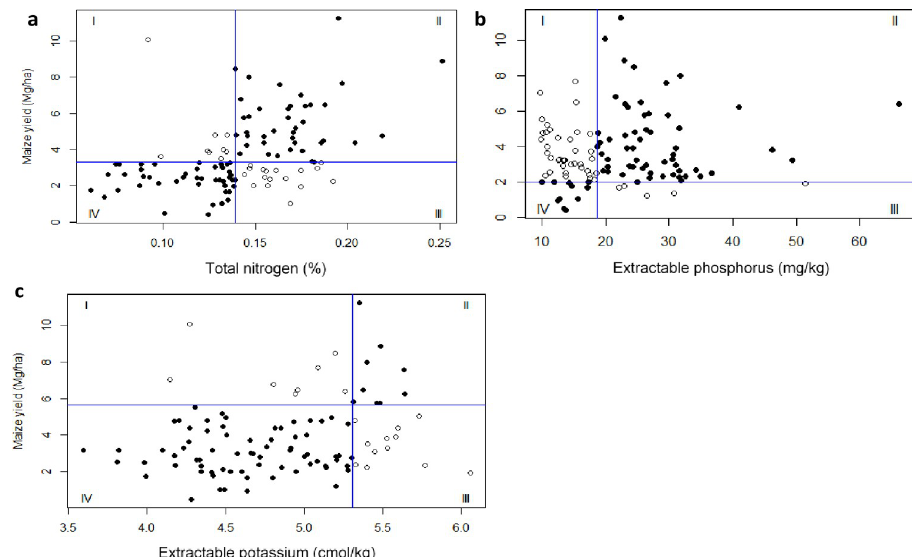
Fig 6. Soil test critical values with the Cate-Nelson method analysis for a ) Nitrogen, b ) Phosphorus and c ) potassium. The intersection of blue lines, the vertical and horizontal line of the x, and y represents critical values for soil test values beyond which crop response is unlikely. The black dots are characterized as responsive plots while the white dots are non-responsive